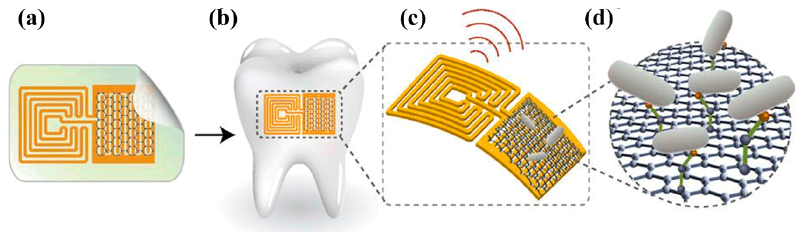
Figure 8. Graphene-based RF/microwave biosensor for the detection of bacteria: ( a ) Graphene patterned onto bioresorbable silk and contacted with wireless coil; ( b ) bio-transfer of the nano-sensing architecture onto the surface of a tooth; ( c ) magnified schematic diagram of the sensing element; ( d ) binding of pathogenic bacteria by peptides self-assembled on graphene (reprinted with permission from [27]).